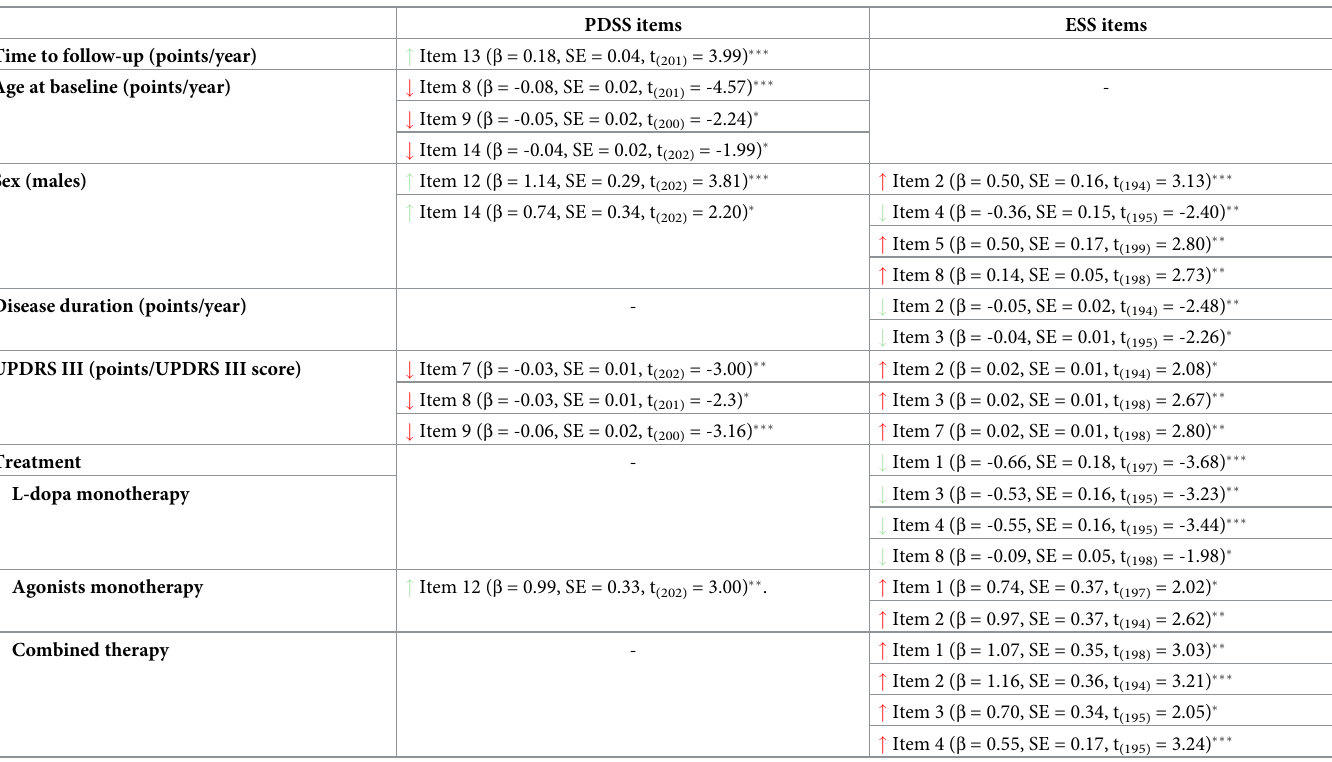
Table 4. Rate of changes in sleep disturbance and daytime sleepiness items based on linear mixed models analysis. PDSS items ESS